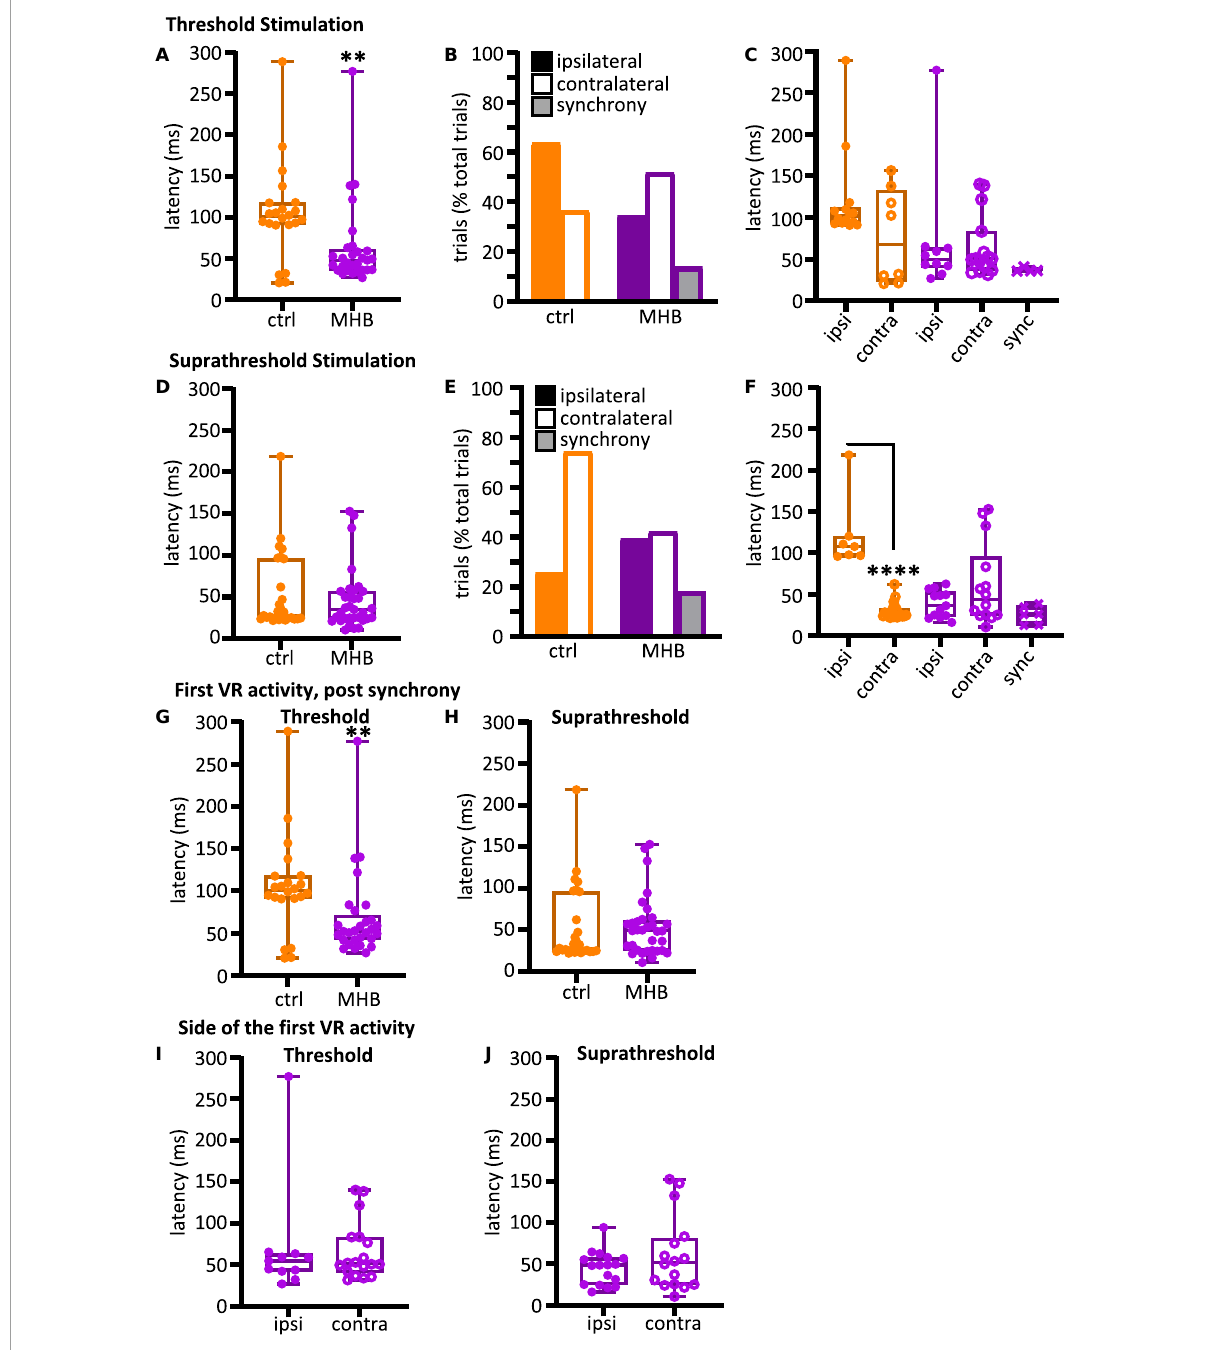
FIGURE4 Midbrain-hindbrain border (MHB) lesion leads to changes in latency and side of fictive swim initiation. (A) Latencies (ms) to the first VR burst after threshold electrical stimulus was delivered to the trunk skin in control and MHB-lesioned animals. Mann-Whitney test p = 0.0049, controls 100.9, 91.02–117.8 ms vs MHB lesioned 48.1, 36.24–61.4 ms; data reported as median, 25–75 percentile. Ctrl: n = 5 tadpoles, trials = 22; MHB: n = 7 tadpoles, trials = 29. (B) Percentage occurrence (% total number of trials for each experimental group) of the first VR burst after threshold electrical stimulation in control (orange) and MHB-lesioned animals (violet). Ctrl ipsilateral 63.6% (14/22 trials), contralateral 36.4% (8/22 trials); MHB ipsilateral 34.5% (10/29 trials), contralateral 51.7% (15/29 trials), synchrony 13.8% (4/29 trials). (C) Latencies (ms) to the first VR burst after threshold electrical stimulus delivered to the trunk skin in control (orange) and MHB-lesioned (violet) animals. Solid circles represent latencies to ipsilateral first VR burst, open circles represent latencies to contralateral first VR burst, and crosses represent VR bursts recorded simultaneously on both sides of the body. Mann-Whitney test for the ctrl group, p = 0.365; Kruskal-Wallis test for the MHB-lesioned group, p = 0.1859. Ctrl